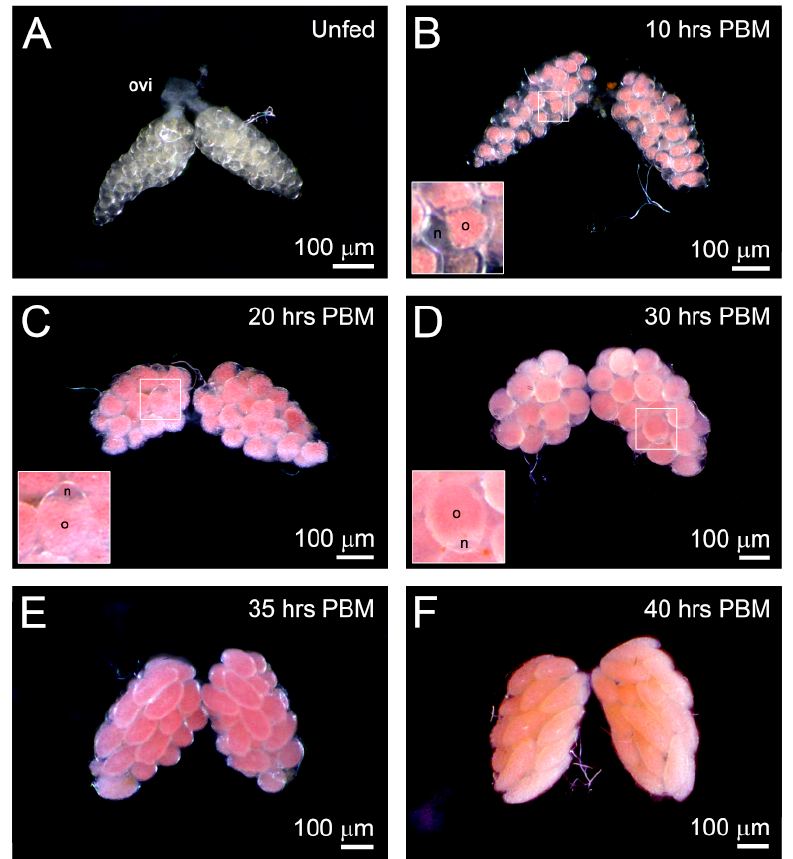
Figure 2. Morphological time course of the ovarian development of F. taiwana after a blood meal by light micrographs. ( A ) A pair of ovaries from an unfed female. The transparent ovaries consist of arresting primary follicles. ( B – F ) A pair of ovaries from females after a blood meal. ( B ) At 10 h post-blood meal (PBM), the insect shows the oocyte appear pink-colored with transparent nurse cells and follicular epithelium surrounding the oocyte. ( C ) At 20 h and ( D ) 30 h PBM, the follicular epithelium became thinner and invisible. ( E ) At 35 h PBM, the size of the ovary significantly increased and the nurse cell became barely visible. ( F ) At 40 h PBM, the follicles are approaching maturation. Insets: enlargement of developing follicles in the ovary. ovi: common oviduct; o: oocyte; n: nurse cell; PBM: post-blood meal. All females were maintained at 28 °C before dissection.